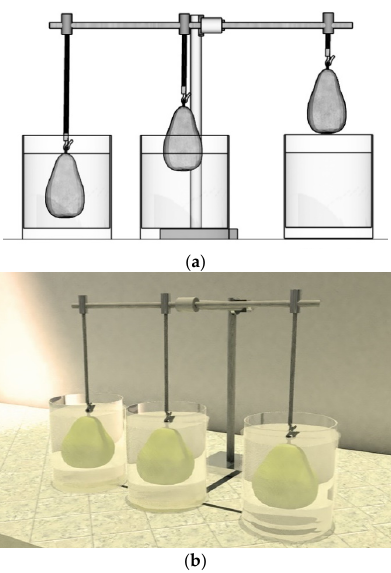
Figure 11. Dip ‐ coating prototype. ( a ) A schematic view of pears’ dip ‐ coating process, ( b ) a detailed Figure 11. Dip-coating prototype. ( a ) A schematic view of pears’ dip-coating process, ( b ) a detailed picture of the prototype. picture of the Fifteen pears of each treatment were selected periodically for the analysis. Evaluations of pears’ physical ‐ chemical and mechanical properties occurred at days 0, 3, 7, 10, 14, and 21. Microbiological analysis occurred during days 0, 3, 6, 9 and 12. Sensorial properties were measured at days 0, 5 and 10.